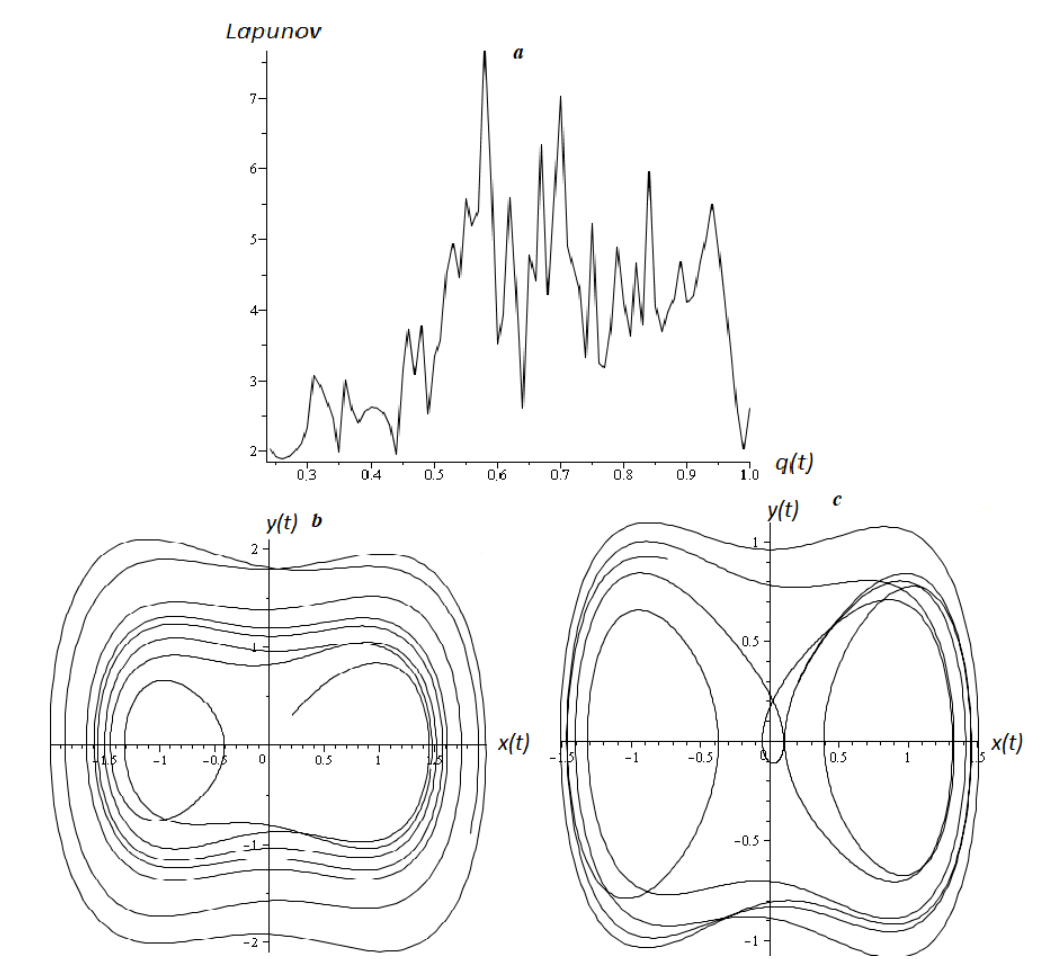
Figure 3. ( a ) Range of Lyapunov exponents from q and ( b ) phase trajectories at q = 0.6 and ( c ) q =